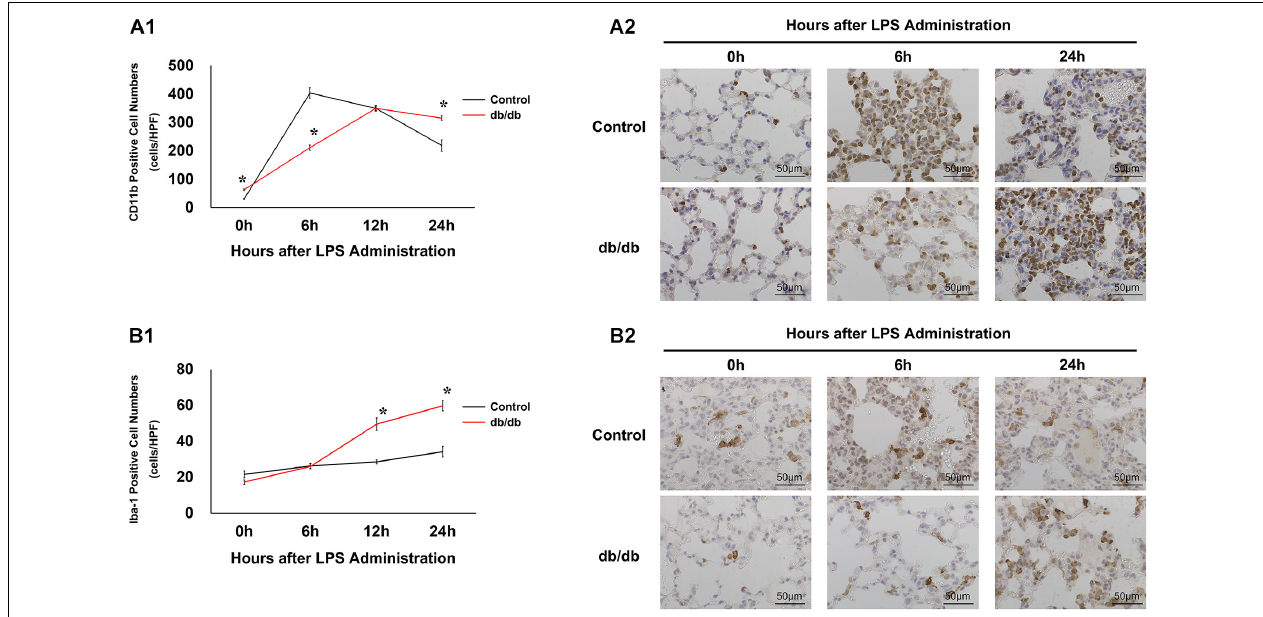
FIGURE 3 | Modulation of inflammatory cells under endotoxemic conditions. (A1) CD11b-positive cells were quantified as numbers of cells per high-power field. (A2) Representative images of CD11b cells in immunostained lung specimens. (B1) Iba-1 positive cells were quantified as the number of cells per high-power field. (B2) Representative images of Iba-1 in immunostained lung samples. *, P < 0.05.